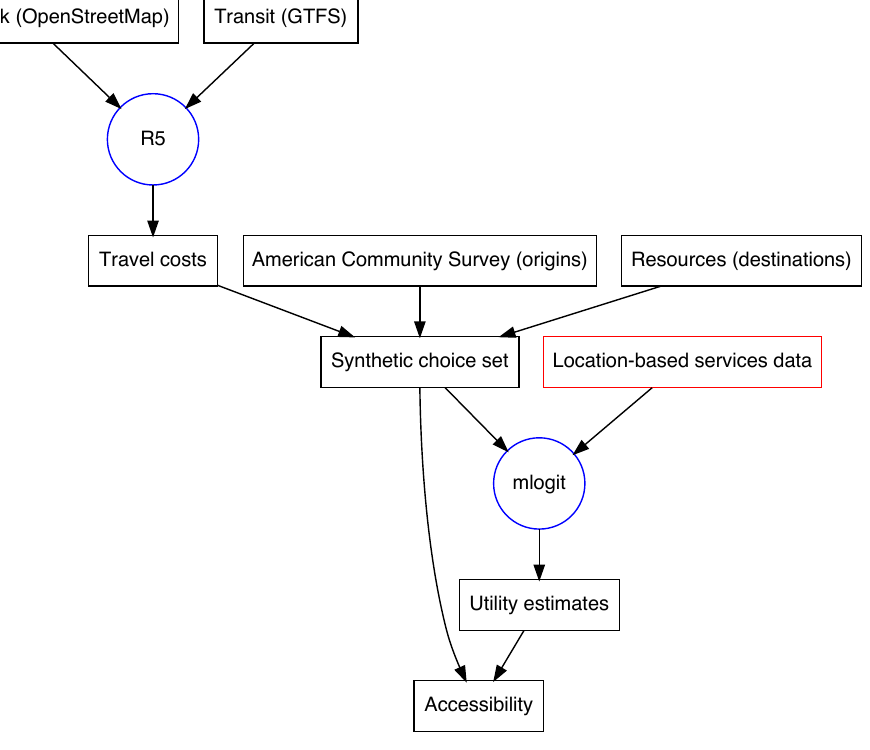
Figure 1. Diagram of the data assembly